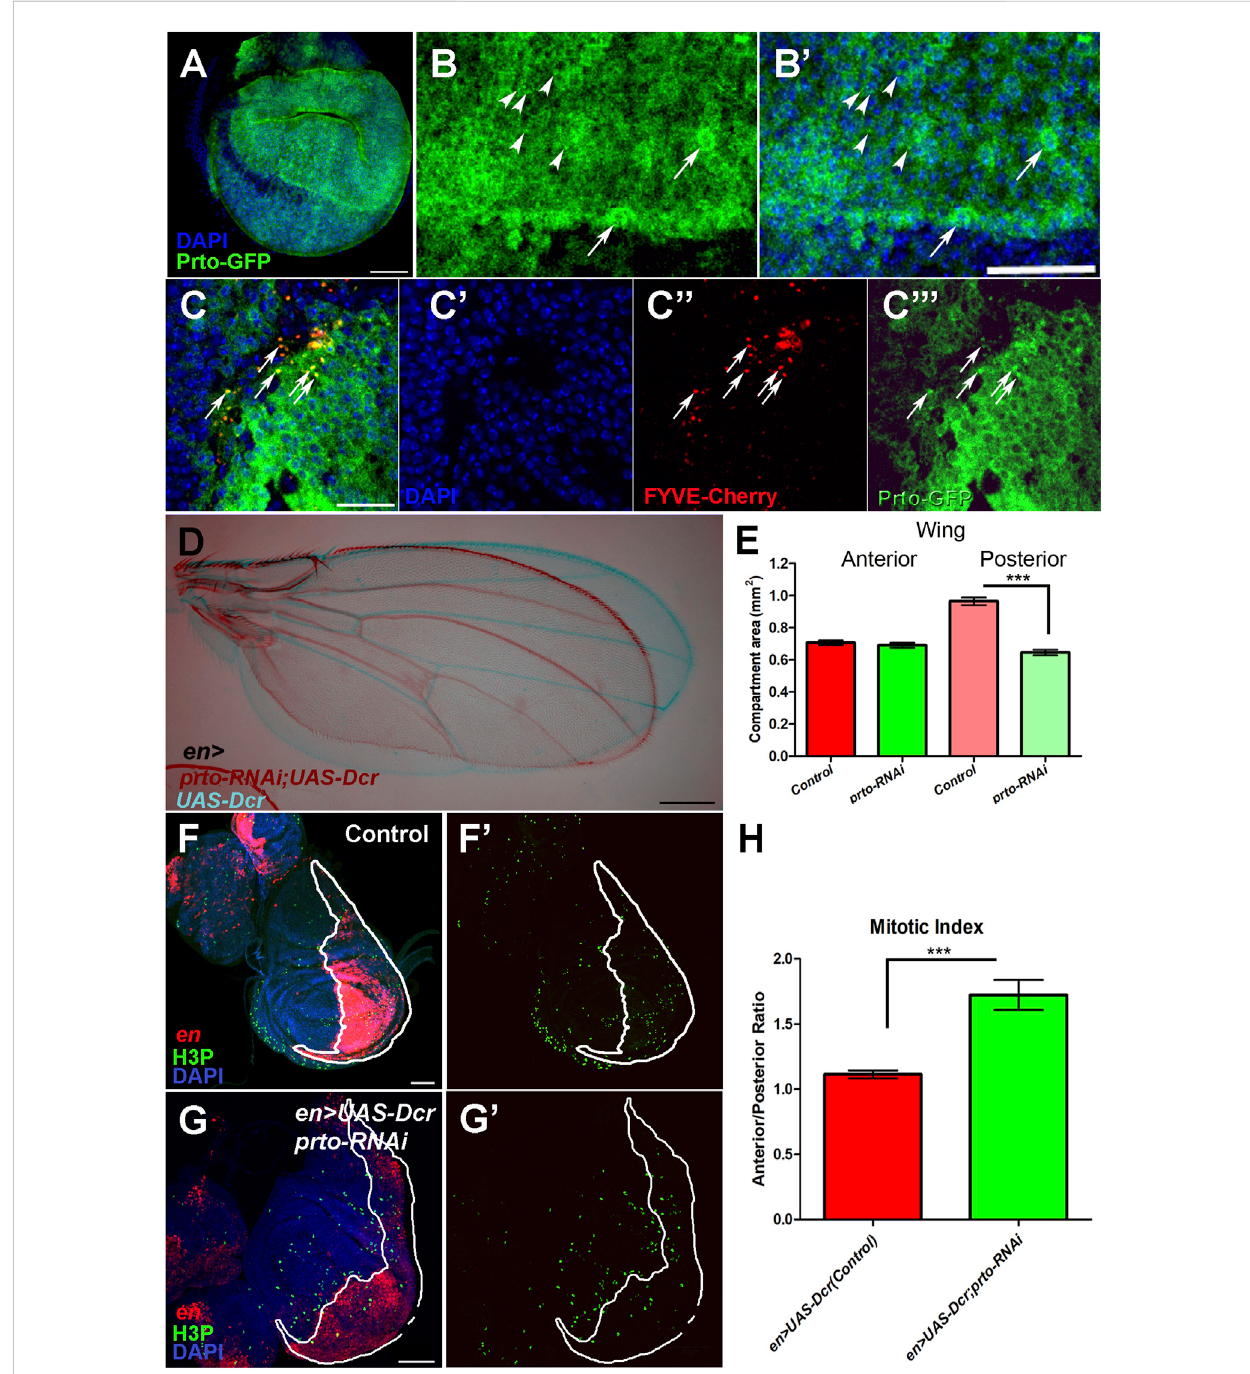
FIGURE 6 prto is required for proper growth of the Drosophila wing. (A) Prto-GFP expression in L3 imaginal disc using the Dlmo-Gal4 driver shows that Prto peptides are localised in the plasma membrane. Scale bar 60 µm. (B – B 9 ) Higher magni fi cation of (A) , showing Prto-GFP peptides (B – B 9 ) in the plasma membrane of epithelial cells and in intracellular puncta (arrowheads) and nuclei (DAPI, (B 9 ) ). Scale bar 40 µm. (C – C - ) Colocalization of Prto-GFP and FYVE-Cherry is observed in wing imaginal disc (arrows). Merged image (C) showing nuclei (DAPI; (C 9 ) ), endosomal marker (FYVE-Cherry (C 99 ) ) and Prto-GFP (C - ) . Scale bar 20 µm. (D) Overlay of a control ( en > UAS-Dcr/+ ; blue) and en > UAS-Dcr;prto-RNAi (maroon) adult wing showing a reduction of posteriorregion.Scalebar200 µm. (E) Measurementoftheanteriorandposteriorcompartmentsofcontroland prto KDwingsshowingthattheposterior compartmentisreduced in prto KDs.Two-tailedMann Whitney testwasperformed. n = 12,error barsrepresent 95% CI,***= p < 0.0001.Nosigni fi cance p > 0.05 was observed in anterior compartment. ( (F – F) ′ Distribution of Histone 3 phosphorylation (green) in control en > UAS-dsRed wing imaginal discs andposteriorcompartmentlabelledinred. (G – G 9 ) en > UAS-dsRed;prto-RNAi wingimaginaldisclabelledas in (F) .Scalebar50 µm. (H) Mitotic indexratio is the number of positive H3P cells anterior compartment divided by the number positive H3P in posterior compartment (white outlined red staining). Controlwingimaginaldiscsisaround1.However,themitoticindexratioin en > UAS-dsRed;prto-RNAi ishigherduetoalowernumberofcellsinposterior compartment undergoing mitosis. Two-tailed Mann Whitney test was applied. n = 13, error bars represent 95% CI, *** = p <